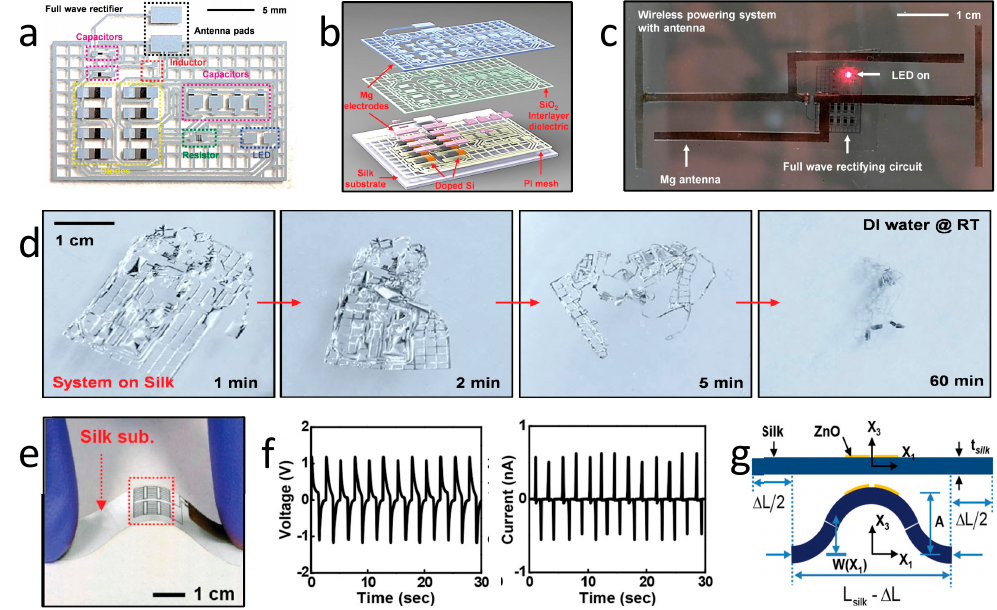
Figure 7. Flexible and biodegradable power harvesters. ( a ) A schematic illustration of transient RF power scavenging circuits. ( b ) A schematic illustration of an exploded view of the device. ( c ) An image of the device powered wirelessly with an RF transmitter and an Mg-receiving antenna. ( d ) Degradation process of the RF power harvester ( e ) Image of a soft and transient ZnO mechanical energy harvester on a silk substrate. ( f ) Output voltage and current ability during cycles of bending. ( g ) The theoretical shape for the buckling of a device under compression. Reproduced with permission from [25,104].